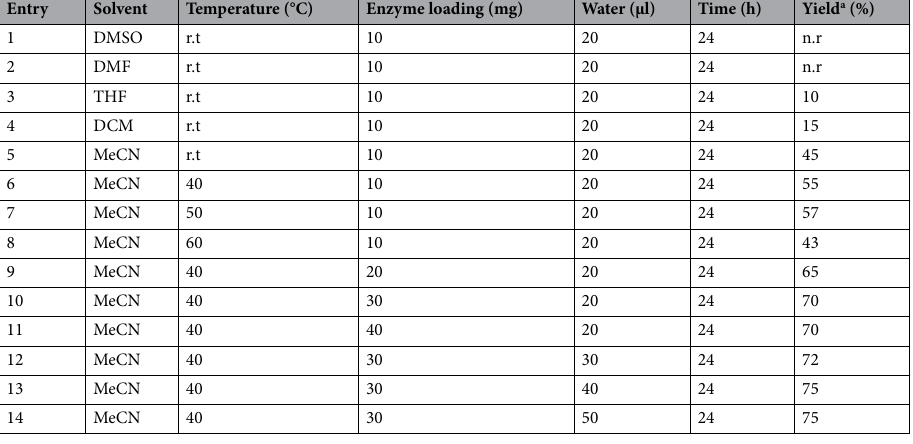
Table 2. Optimization of the reaction